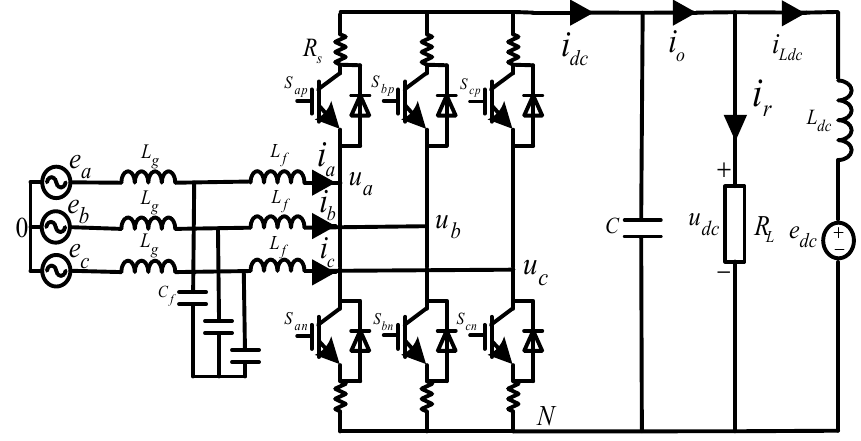
Figure 1. Topology of a three phase bidirectional AC-DC converter.